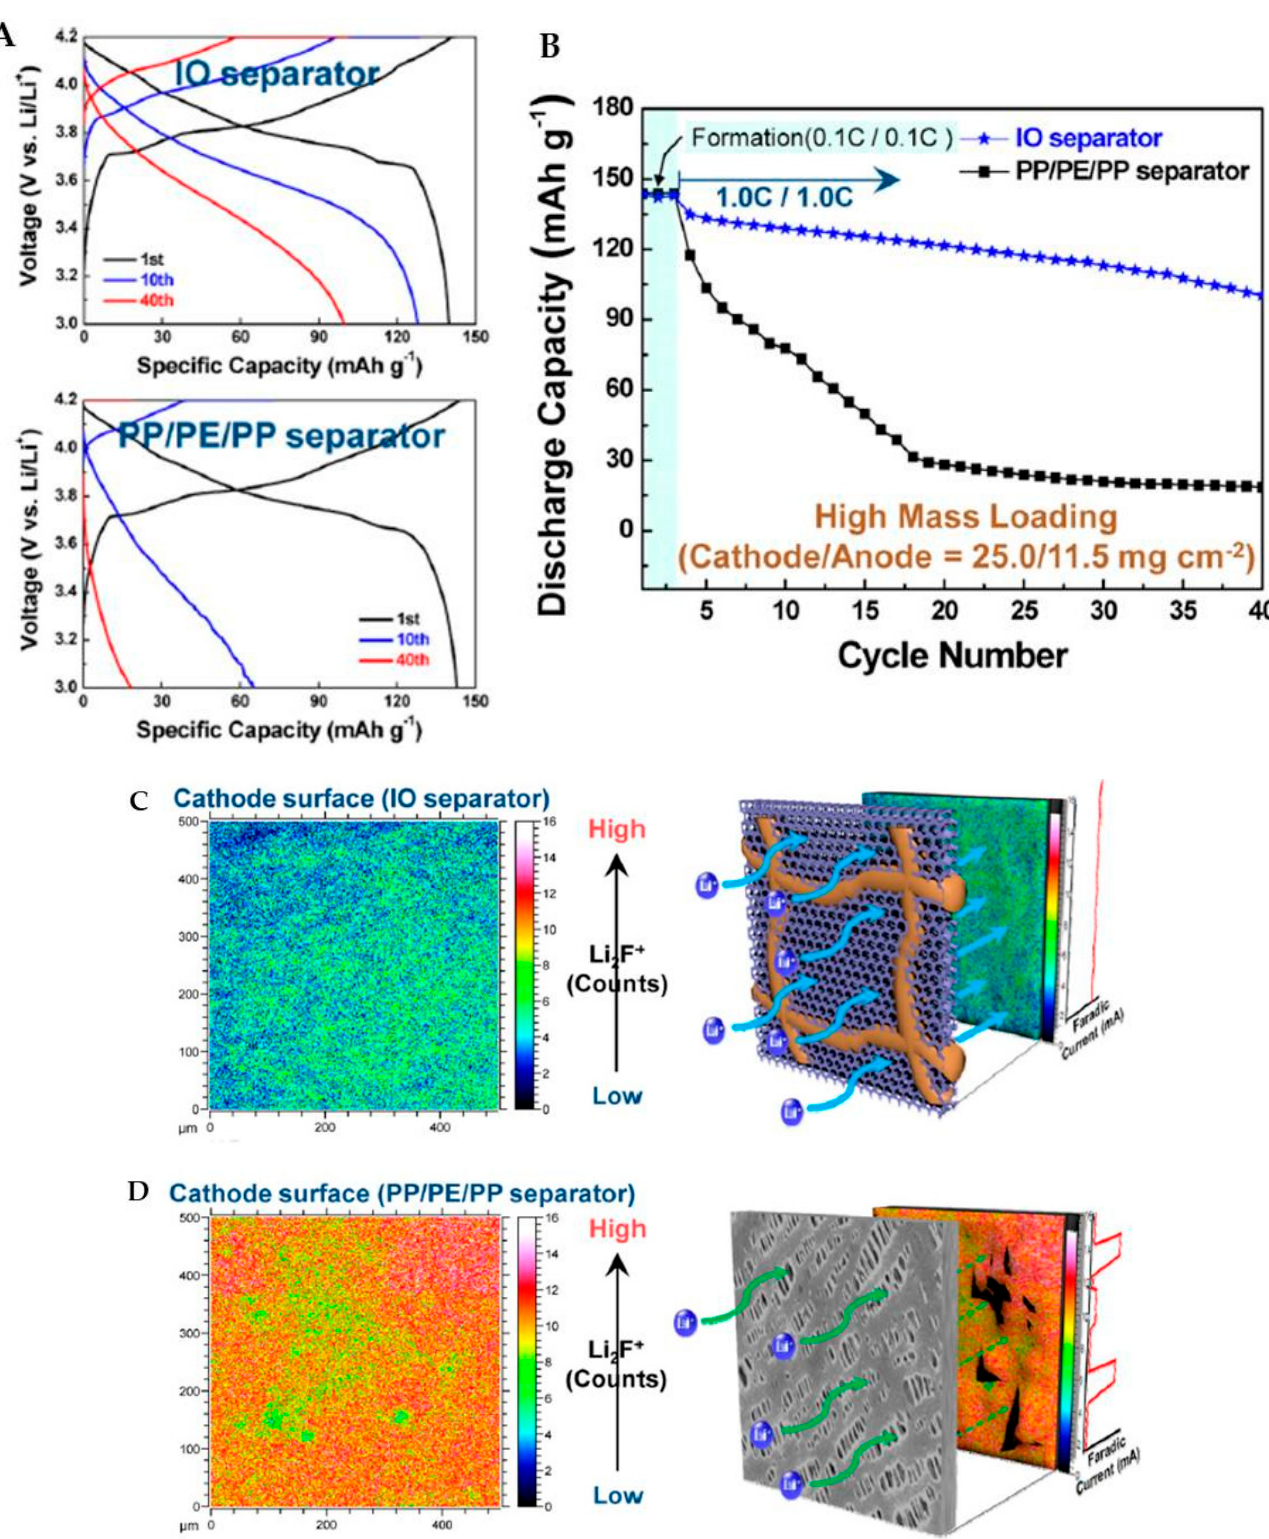
Figure 5. ( A , B ) are cell (LiCoO 2 cathode/graphite anode) performances in the presence of IO separator (SiO 2 /ETPTA = 74:26 ( v / v )) and PP/PE/PP separators. ( C , D ) are the TOF-SIMS surface Li 2 F + images of both the membranes and the graphical representation of Li + transfer from anode to the cathode through the membranes during the charge and discharge process. Reprinted/adapted with permission from ref. [69]. Copyright 2014,